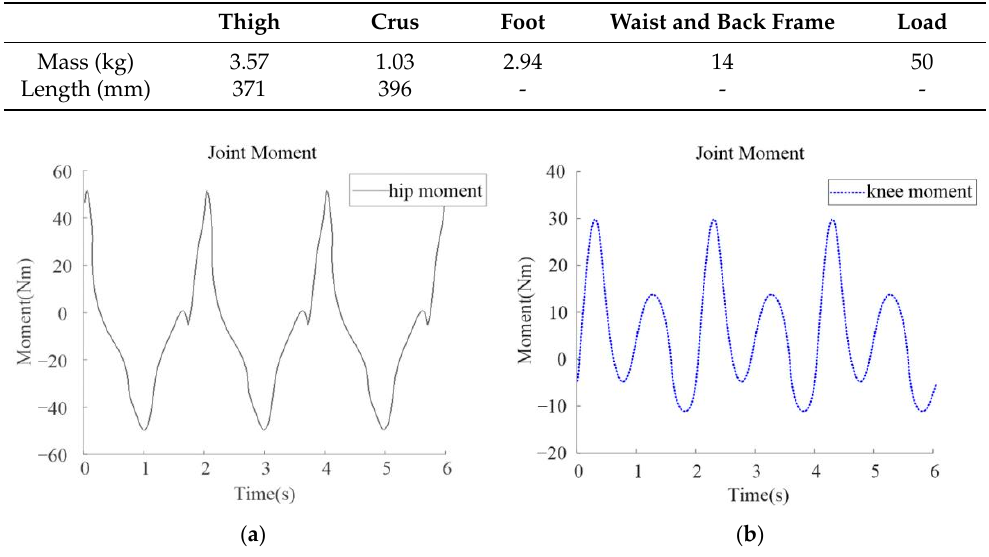
Table 3. The exoskeleton parameters.